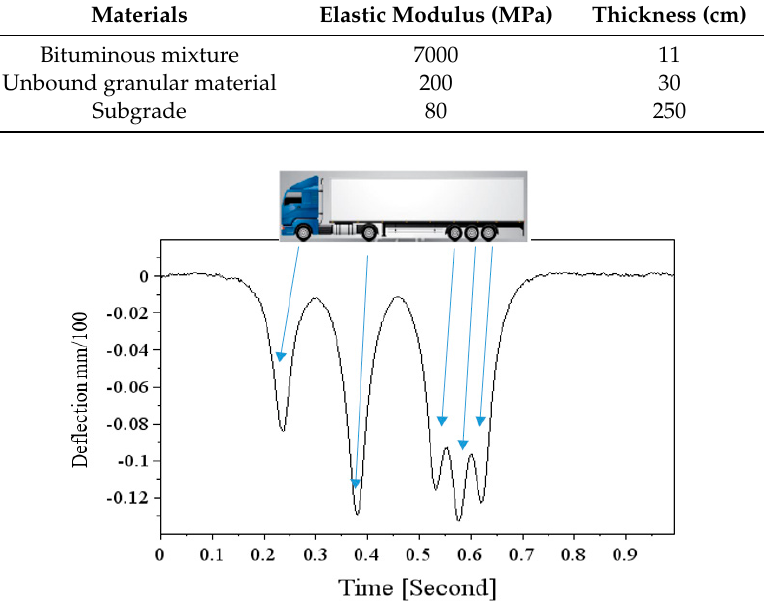
Figure 2. Deflection signal obtained with the ALIZE pavement-modelling software, corresponding to a 5-axle truck load. Table 1. Pavement model.